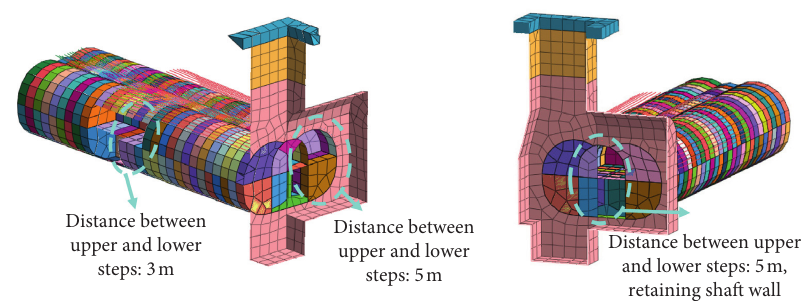
Figure 9: Construction procedure of the optimization scheme.